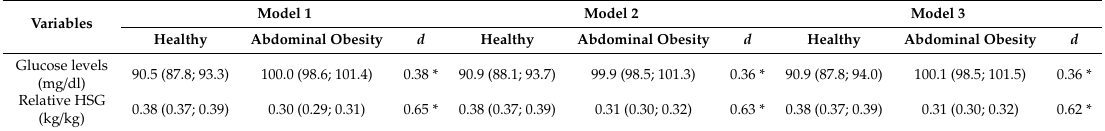
Table 2. Comparison of the marginal mean values of fasting glucose levels and relative HSG according to central obesity status.